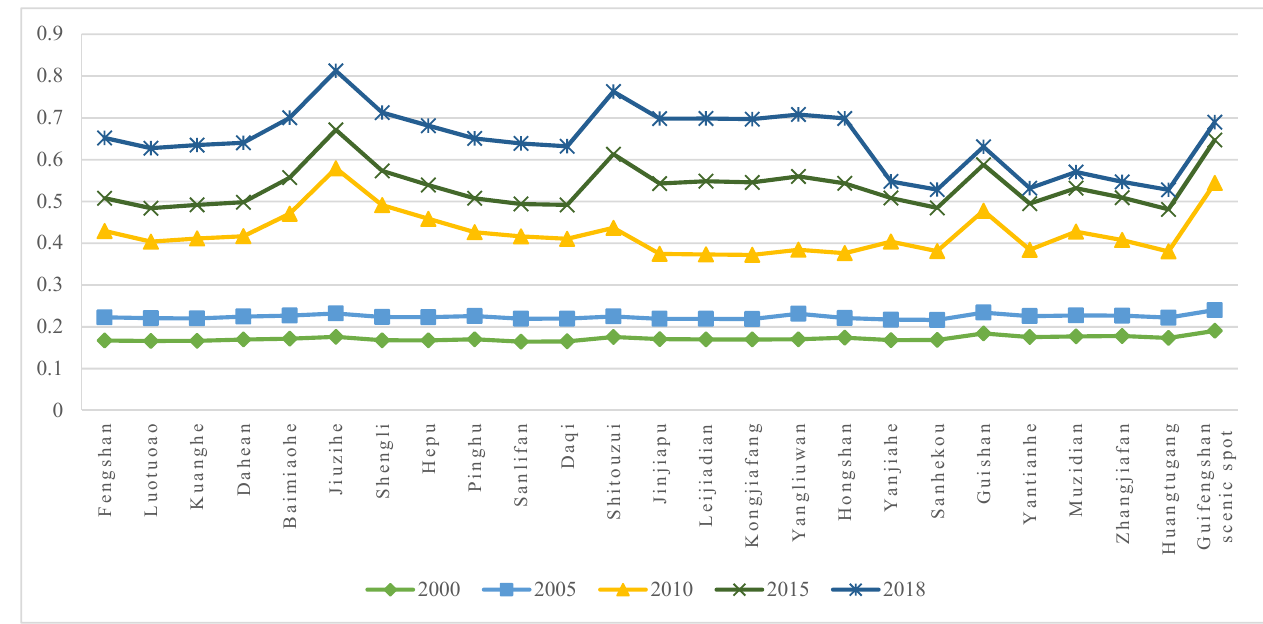
Figure 4. TESI of each township in Huanggang Dabieshan UGGp from 2000 to 2018.